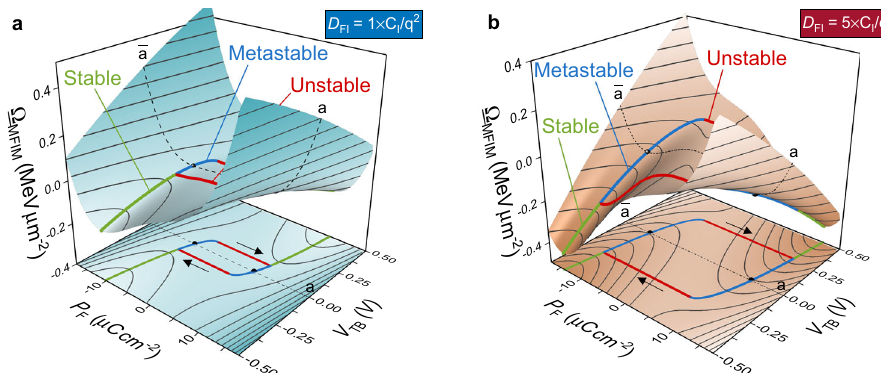
Fig. 2 Surface charge density at the ferroelectric-insulator interface destabilizes the Grand Potential energy landscape of the free-charge-conducting metal-ferroelectric-insulator-metal ( c -MFIM) system. The Grand Potential energy ( Ω MFIM ¼ Ω MFIM = A ) landscape is plotted as a function of the ferroelectric polarization P F and the applied voltage V TB for an interface state density ( a ) D FI = 1× C I / q 2 and ( b ) D FI = 5 × C I / q 2 , where C I is the capacitance of the insulator layer and q is the electron charge. (Note that the free energy landscape shown in Supplementary Fig. S3a corresponds to the case of D FI = 0). a , b The stable, metastable, and unstable equilibrium states of the c -MFIM system (at constant applied voltage V TB ) are indicated for both cases. In addition, the trajectory (aa) along the energy landscape corresponding to a constant V TB = 0 V is indicated. Comparing the energy landscapes of a , b demonstrates that increasing the interface state density D FI deforms the Grand Potential energy landscape, resulting in an increased hysteretic device operation of the c -MFIM system.